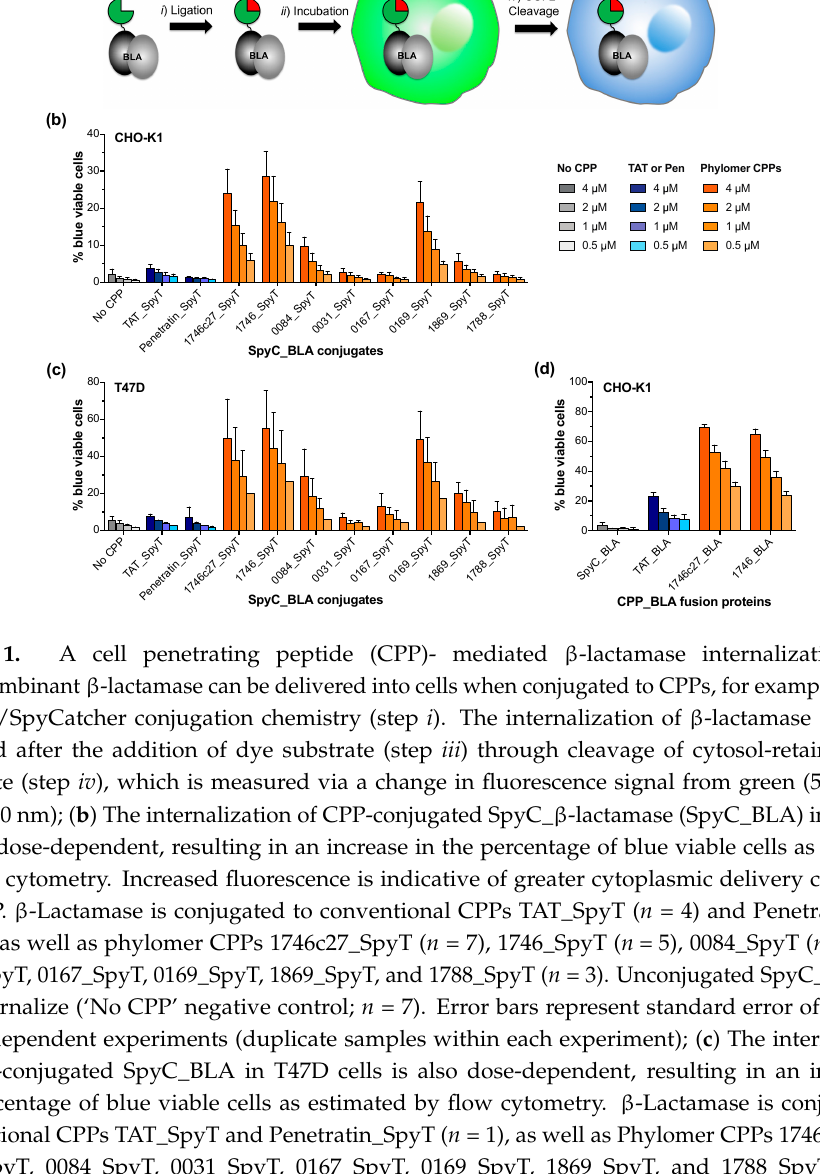
shift as percentage of blue fluorescent CHO-K1 or T47D cells after 1 h (Figure 1b,c, respectively). Successful internalization of β -lactamase was dose- and CPP-dependent, with a limit of detection of 500 nM for conjugated protein. The potency of TAT and Penetratin CPPs was comparable to those measured by independent split-GFP complementation assays [14].